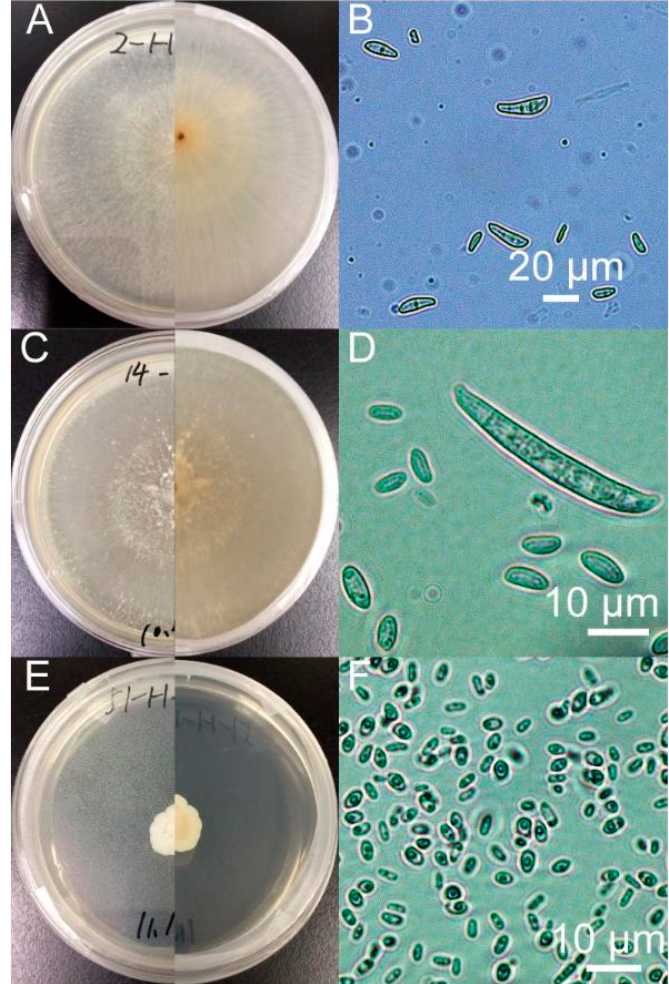
Figure 2. Morphological characteristics of Fusarium sp., Neocosmospora metavorans , and Meyerozyma guilliermondii . ( A , B ): colony and conidial spores of Fusarium sp., respectively, on PDA (25 °C, dark, 12 days); ( C , D ): colony and conidial spores of N. metavorans , respectively, on PDA (25 °C, dark, 14 days); ( E , F ): colony and conidial spores of M. guilliermondii , respectively, on PDA (25 °C, dark, 9 days). Table 1. Relative dominance (RD, %) and frequency of occurrence (FO, %) of fungal species isolated from head, thorax, and abdomen of reared female adults of Euwallacea interjectus in this